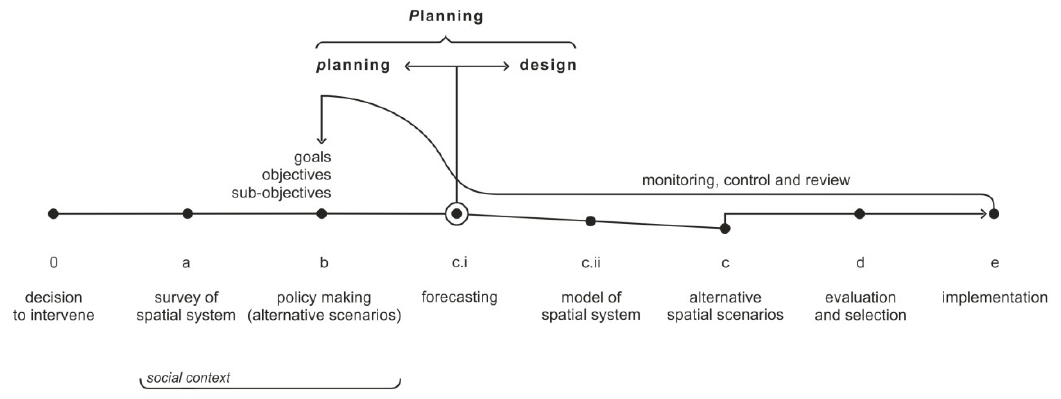
Figure 2. The articulation of planning as part of the whole planning process with design as the end process of planning, presented on the methodological axis of comprehensive planning.